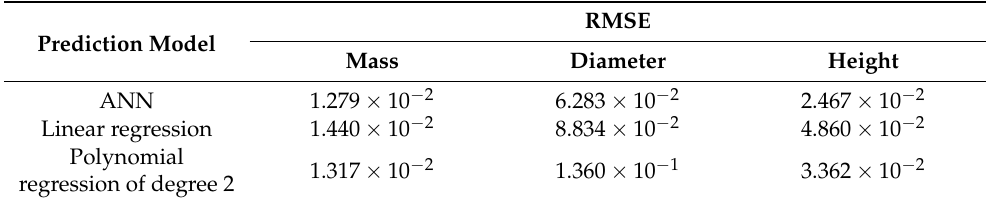
Table 9. Root mean square errors (RMSEs) of normalized test data for prediction models learned by the linear relation group (packing time was 3.0–18.0